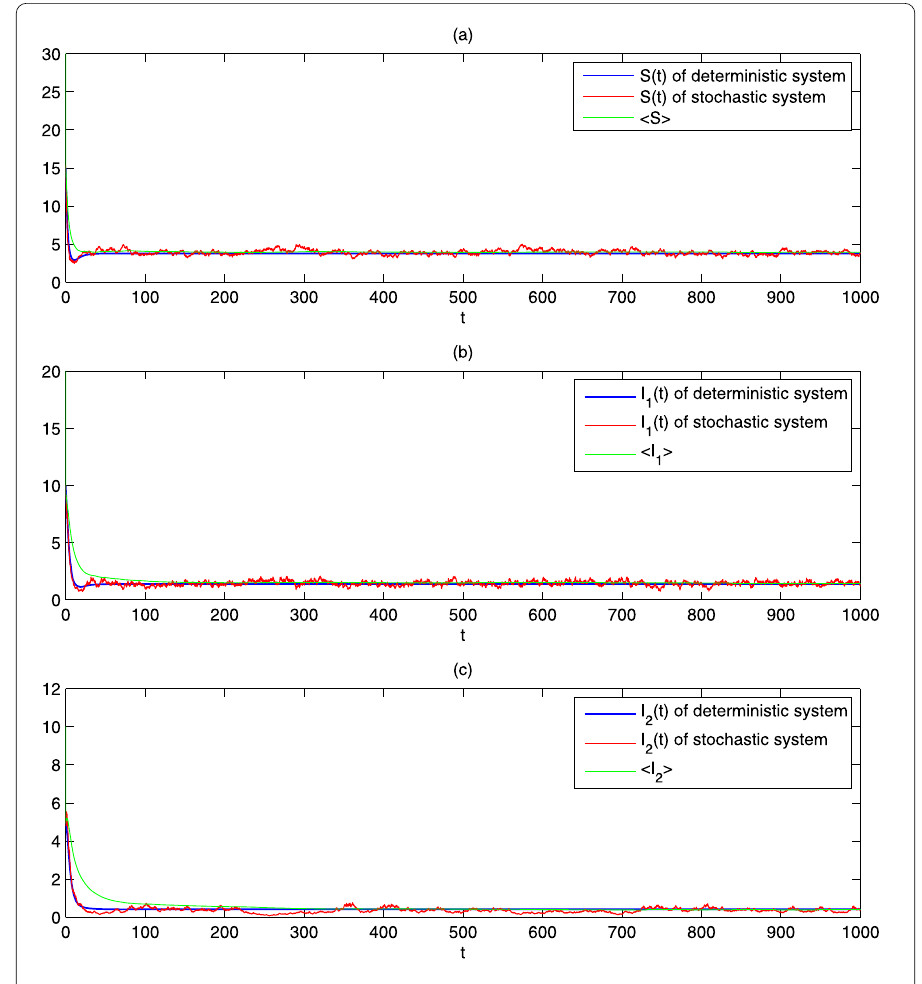
Figure 6 Dynamic behaviour comparisons of S ( t ), I 1 ( t ), I 2 ( t ) in the deterministic and the stochastic SIS system with parameters A = 1, d = 0.1, β 1 = 1.2, β 2 = 1.5, a 1 = 1, a 2 = 1.5, b 1 = 2, b 2 = 1, α 1 = 0.2, α 2 = 0.4, r 1 = 0.3, r 2 = 0.3, σ 1 = 0.2, σ 2 = 0.2. (a) Time series for S ( t ) and (cid:5) S ( t ) (cid:6) . (b) Time series for I 1 ( t ) and (cid:5) I (cid:6) . (c) Time series for I (cid:5) I (cid:6) . 1 ( t ) 2 ( t ) and 2 ( t )